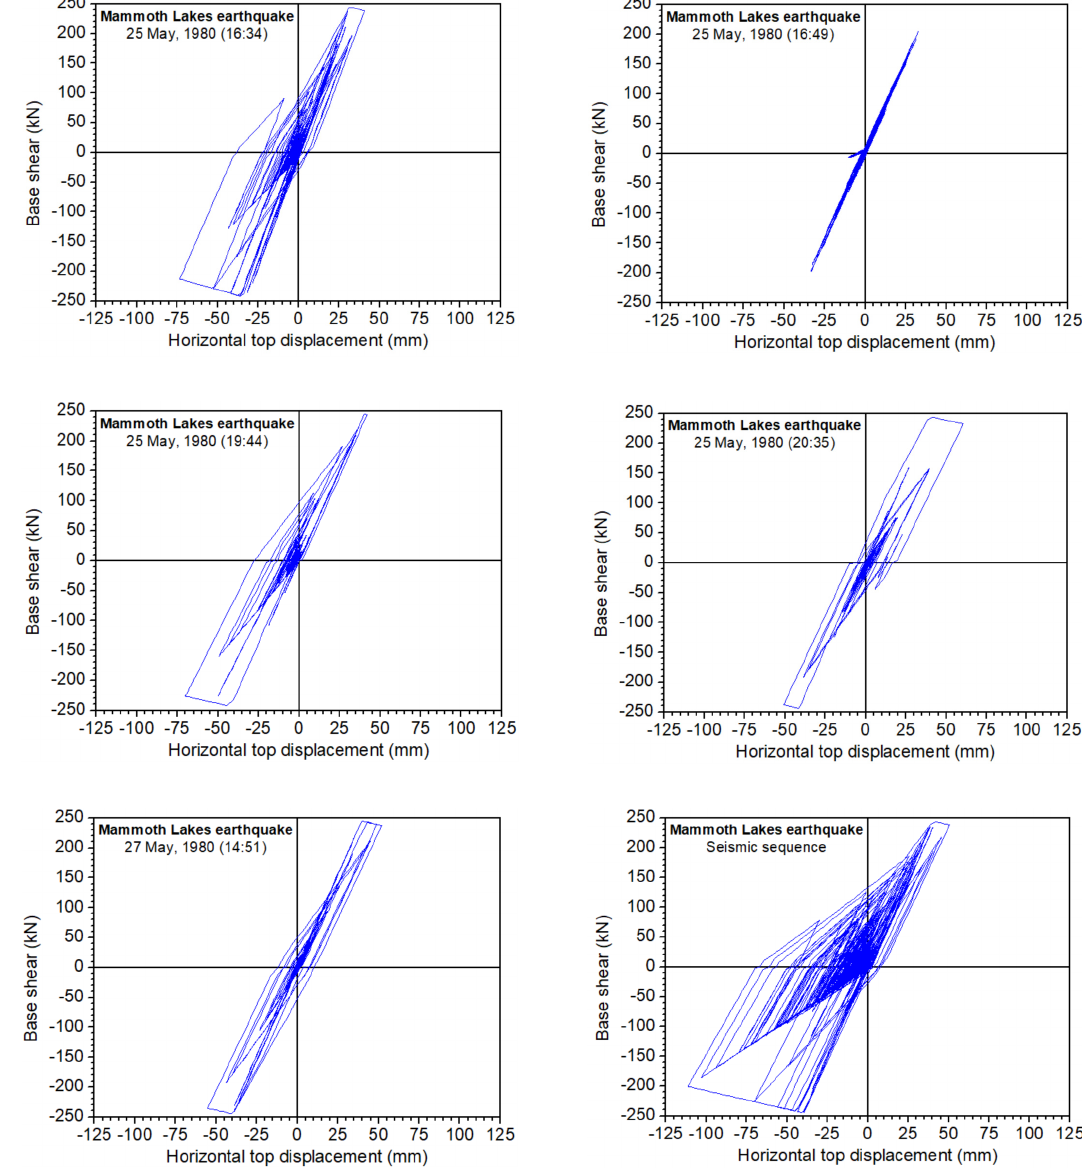
Figure 7. Soil – pile – platform system under the Mammoth Lakes earthquake (25 – 27 May